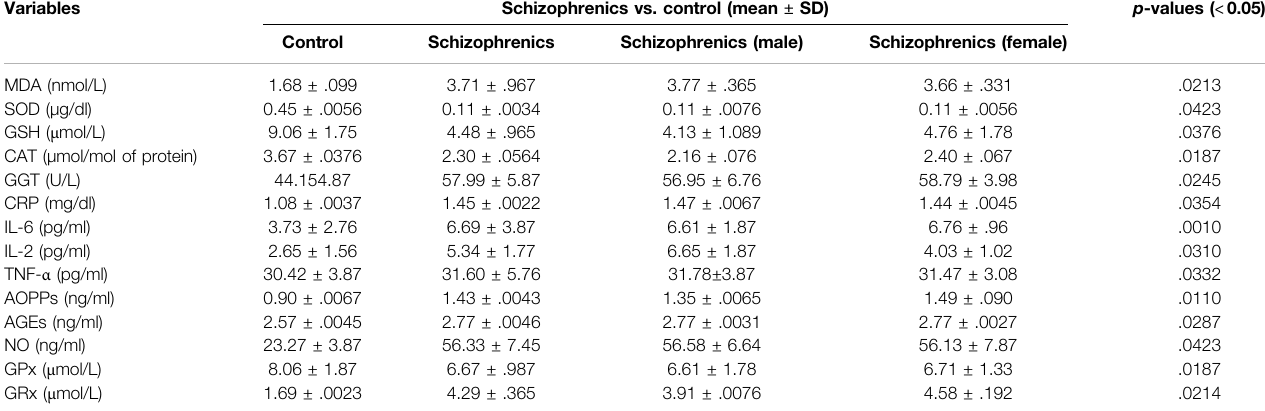
TABLE 4 | Antioxidant pro fi les of schizophrenics versus controls.